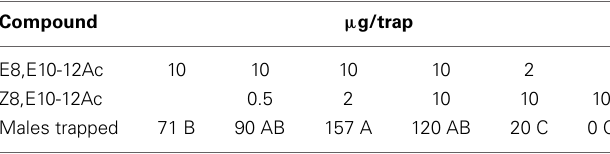
Table 4 | Field attraction of C. splendana males to synthetic pheromone blends in a chestnut orchard (Cévennes; N = 10).